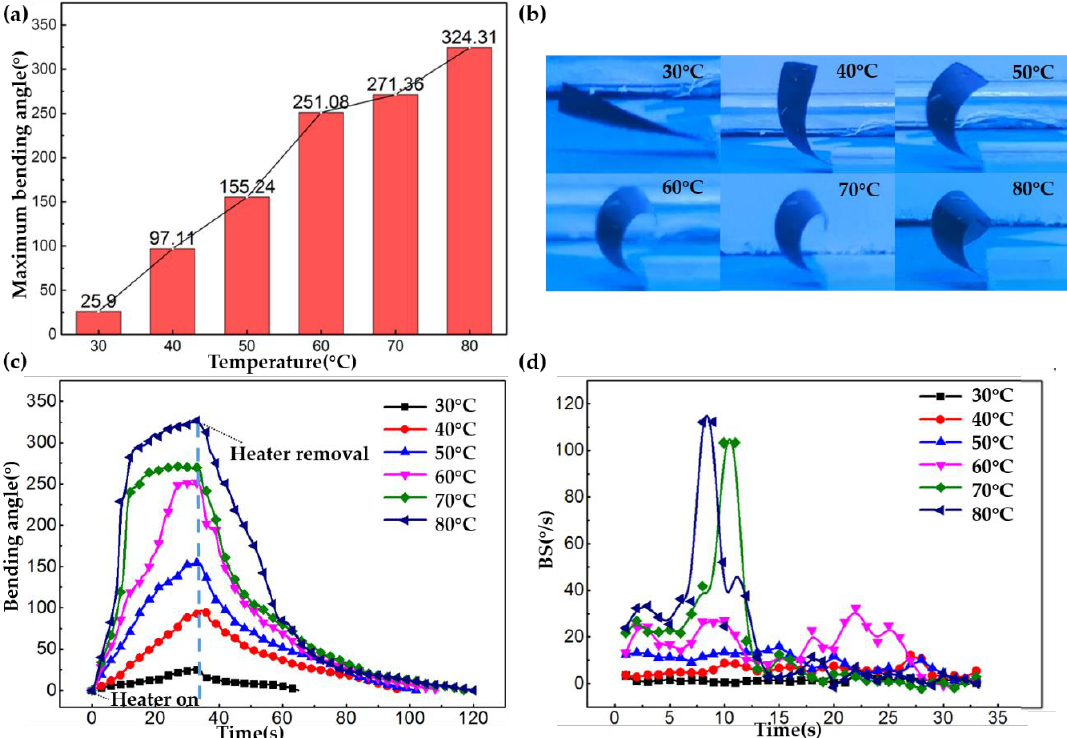
Figure 4. Thermal-responsive behavior of the multilayer membrane (test ambient relative humidity was 30%). ( a ) The maximum bending angle of multilayer membrane upon various temperatures. ( b ) Bending images of the multilayer membrane under different temperatures. ( c ) Bending angle of the multilayer membrane with 15% graphite particle concentrations upon various temperatures. ( d ) Schematic diagram of the multilayer membrane’s BS.